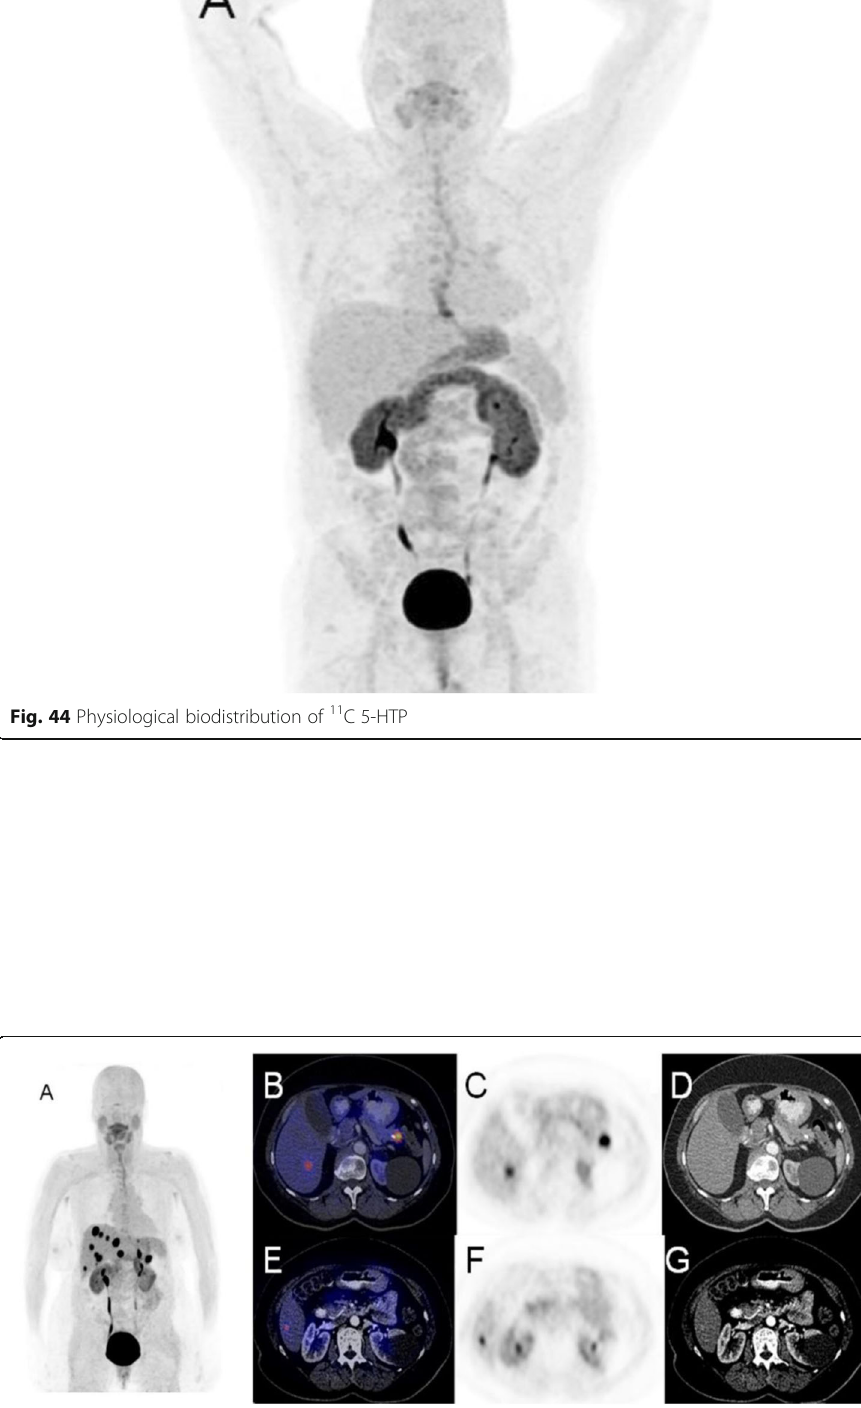
Fig. 45 11 C 5-HTP NET of the pancreas, staging. Clinical history : 65 y.o. woman with pancreatic NET, metastatic to liver. PET/CT findings : MIP ( a ) showing multiple sites of intense tracer accumulation in the upper abdomen. Fused images of PET with diagnostic CT ( b , e ), PET only ( c , f ), and CT only ( d , g ) showing intense tracer accumulation in a lesion in the cauda of the pancreas, with vague contrast enhancement and a calcification on the CT as well as in liver metastases ( b – d